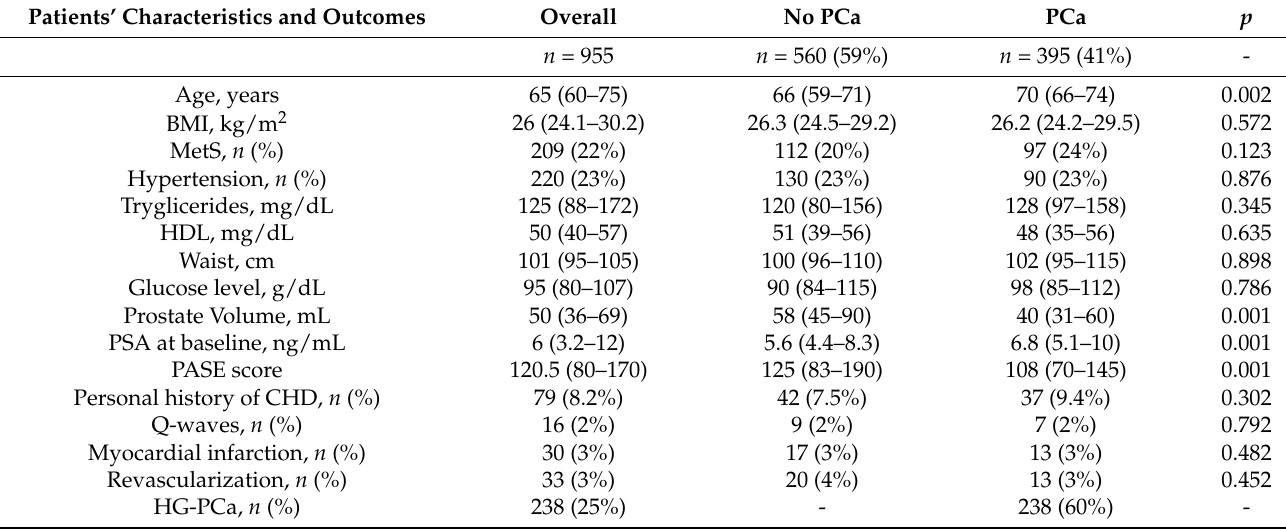
Table 1. Patients’ characteristics and outcomes, according to prostate cancer